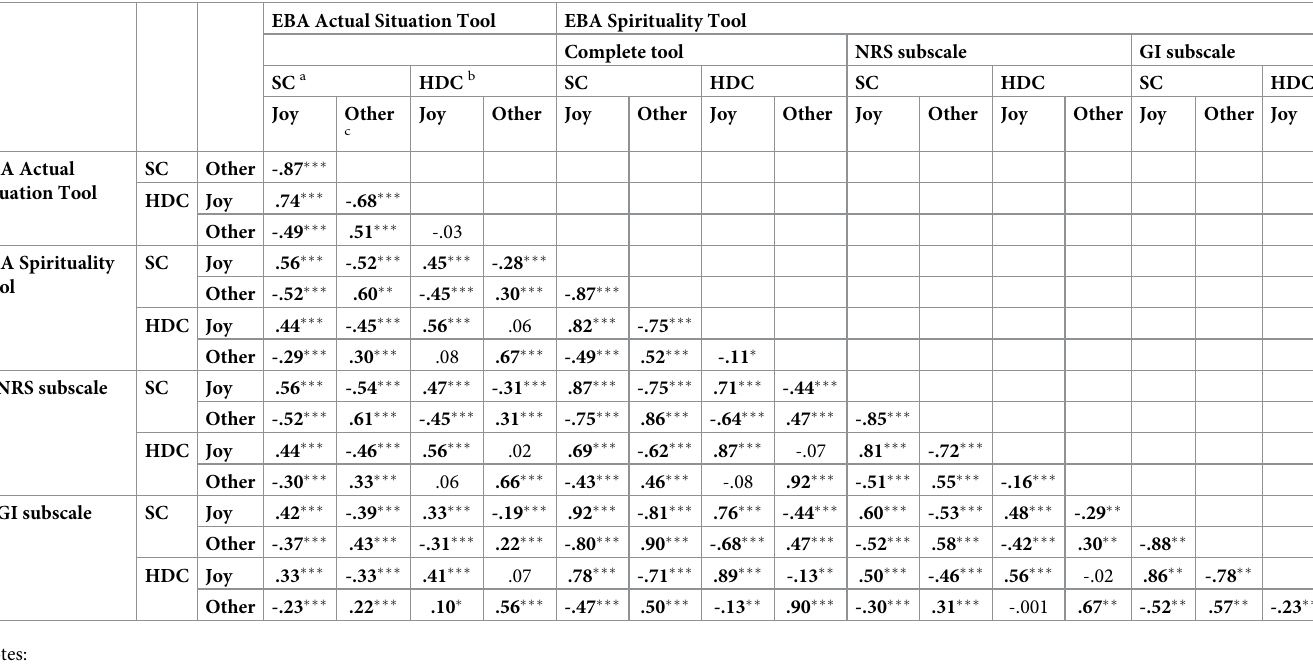
Table 5. Bivariate associations of scores on the EBA actual situation tool and the EBA Spirituality tool (SC a and HDC b ) (complete